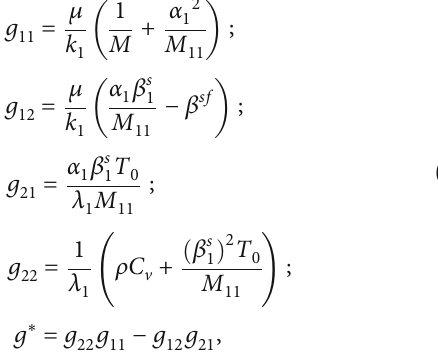
Table 1: Formation properties used to model the uncertainty in the hydraulic fracture